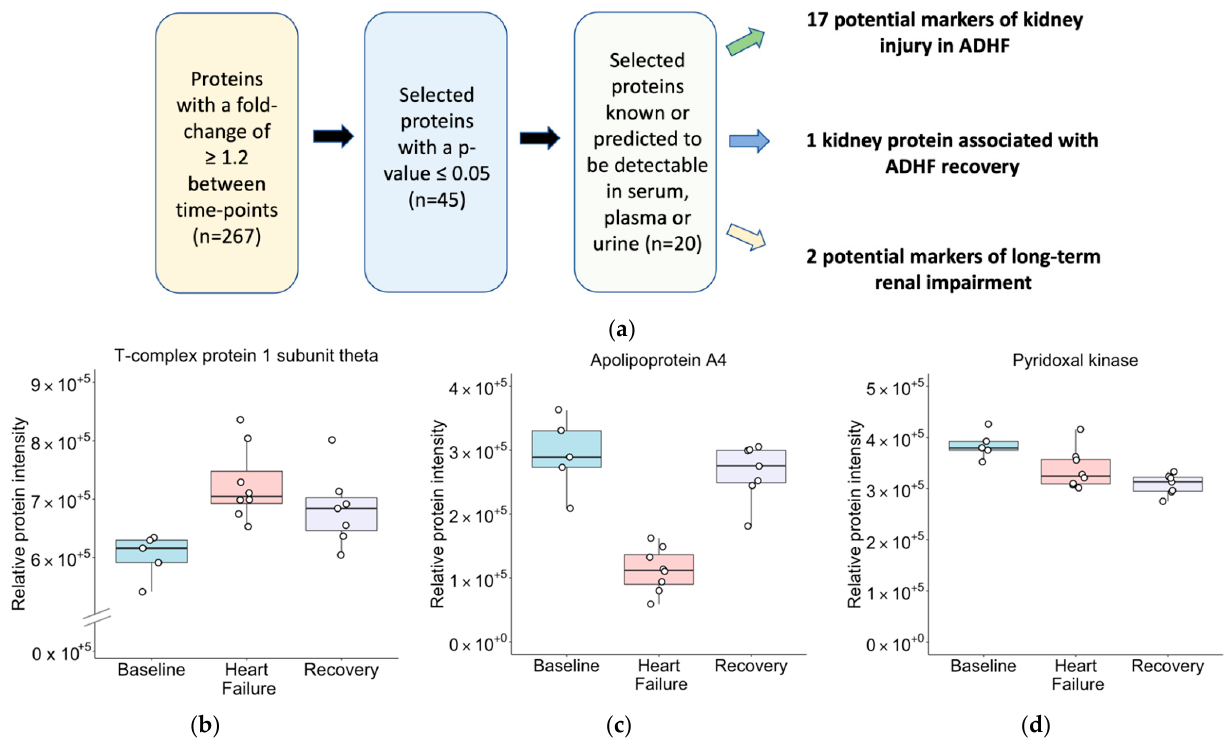
Figure 4. ( a ) Biomarker discovery workflow for candidate markers of renal impairment in ADHF, and ( b – d ) boxplots for proteins of differential abundance detectable in plasma, serum, or urine with adjusted p -values < 0.05 and fold-changes ≥ 1.2. Representative examples of ( b ) proteins of differential abundance between Baseline and ADHF, but not between ADHF and Recovery F (potential markers of kidney injury in ADHF); ( c ) proteins of differential abundance between Baseline and ADHF, and between ADHF and Recovery (kidney proteins associated with ADHF recovery); ( d ) proteins of differential abundance between Baseline and Recovery (potential markers of long-term renal